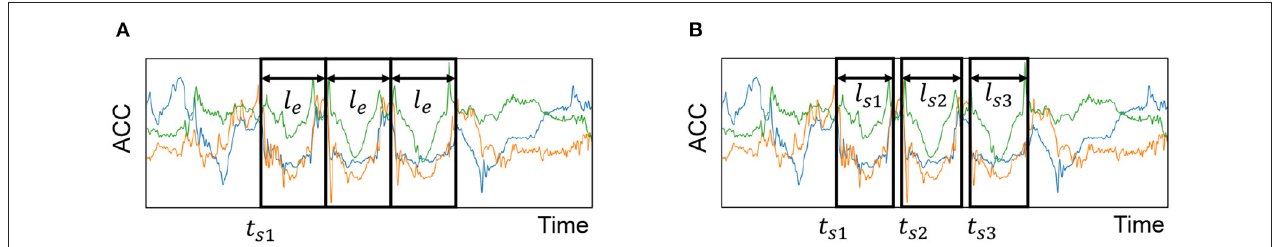
FIGURE 7 | Determining start time and length of each occurrence of a target action in a weakly labeled segment for sit-up workout. (A) Determining rough start time of the first occurrence t s 1 and duration l e . In this case, we assume that the duration of the 2nd and 3rd occurrences is also l e . Therefore, the start times of the 2nd and 3rd occurrences are decided based on t s 1 and l e . (B) Determining start time and duration of each occurrence using optimization.